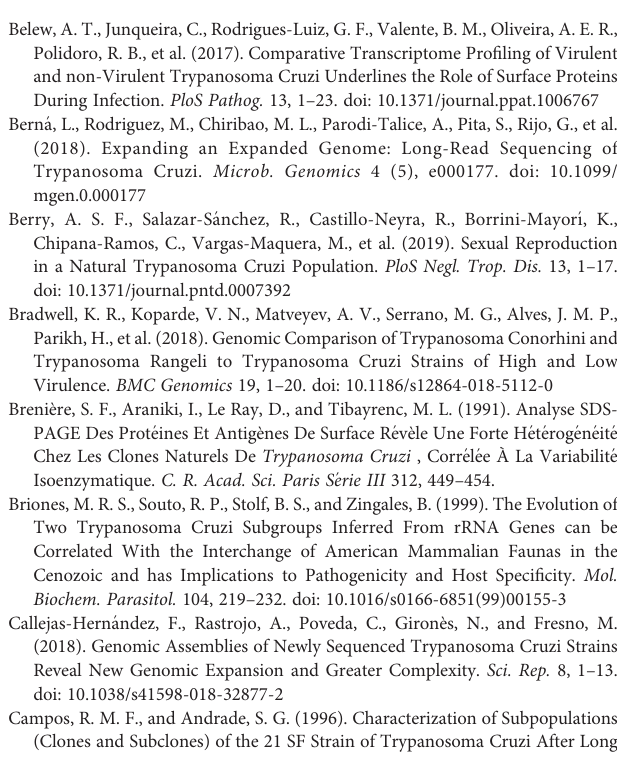
three groups: Hypothetical - genes encoding hypothetical proteins without assigned function; MGF – multigene families encoding surface proteins, such as, trans-sialidases, MASPs, TcMUC, GP63 and DGF1, and nuclear proteins coded by RHS gene family (retrotransposon hot-spot protein); and others – DNA replication genes, kinases, phosphatases, etc. The CLB gene content was compared with those in the ampli fi cation and deletion regions of clone D11 (left). Supplementary Figure 6 | Schematic representation of the in silico chromosomes of non-Esmeraldo-like haplotype showing the gene annotation and chromosomal alterations detected by aCGH in clone D11. Annotation of multigene families in CLB is shown in light blue and the other genes in black. The CNVs detected by aCGH in the clone D11 are shown on the in silico CLB chromosomes. DNA ampli fi cation and deletion are shown in red and green, respectively. The chromosomes and recombination events are shown to scale (Bar=200kb). Supplementary Figure 7 | Molecular karyotypes of clone D11 and the parental G strain. Panel (A) Chromosomal bands were resolved by PFGE and stained with ethidiumbromide.Thevisualizedbandswerenamedusingcapitalletters(21bands, A – U) (Lima et al., 2013) for clone D11 and Arabic numerals (19 bands, 1 -19) (Souza et al., 2011) for G strain. Panel (B) Schematic representation of the molecular karyotype of clone D11 and G strain showing the molecular weight of each band on the right side of the strip. The thickness of the rectangles represents the thickness of each visualized chromosomal band. C) Raw image showing the pulsed fi eld electrophoresis running gel. Note: The karyotype of D11 and the G strain had already been described by Lima et al., 2013 (Lima et al., 2013). The electrophoretic runs shown in Figure S7 were performed in the present work. They have included as a Supplementary Figure to facilitate the understanding of mapping of aCGH alterations in the chromosomal bands of the G strain and clone D11. Supplementary Figure 8 | Raw images showing the pulsed fi eld electrophoresis running gels and Southern blot hybridizations from. Upper Panel. Separation of T. cruzi chromosomal bands on a pulsed fi eld gel (PFGE). Chromosomal DNA was prepared from T. cruzi isolates: clone CL Brener (CLB) used as a reference genome in this study, strain G (parental strain) and clone D11, a single-cell derived of G.